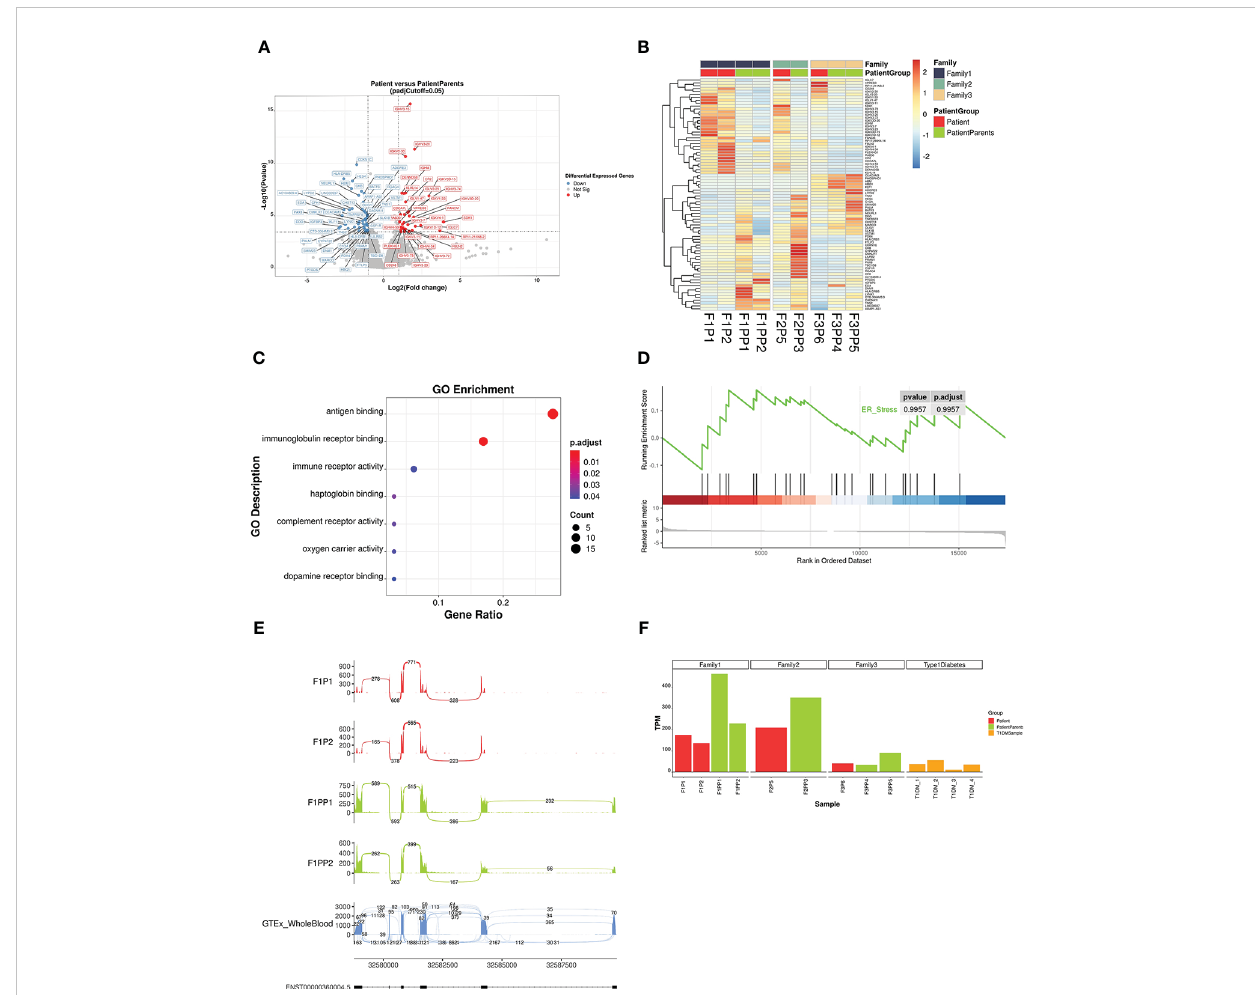
FIGURE 4 Analysis results of differentially expressed genes and splicing abnormalities by RNA sequencing. (A) Volcano plot showing gene expression differences between patients and their parents. Differentially expressed genes with an adjusted p < 0.05 and a fold-change FC ≥ |2| are depicted in red (up-regulated) and blue (down-regulated). (B) Heatmap of all differentially expressed genes. Gene expression levels were quanti fi ed by transcript per million and scaled by gene. Red indicates higher expression level while blue indicates lower. (C) Gene Ontology (GO) enrichment scatter plot of differential expressed genes. The signi fi cance of GO term enrichment is represented by adjusted p -value and mapped to the scatter plot by point colour, while point size indicates the number of candidate genes annotated with a GO term. (D) Gene Set Enrichment Analysis (GSEA) showed that ER stress related genes exhibited little differential expression. (E) Sashimi plot of HLA-DRB1 gene of family 1 patient and their parents. Exon 1 of HLA- DRB1 were not transcribed in patients (Patient 1 and Patient 2), compared with their parents as normal transcripts. The last sashimi plot shows the average level of junction reads from 755 GTEx whole blood samples. (F) The expression level of HLA-DRB1 in different samples. The expression level of HLA-DRB1 was lower in other patients with WFS1 variants and T1DM, compared to the parent group without